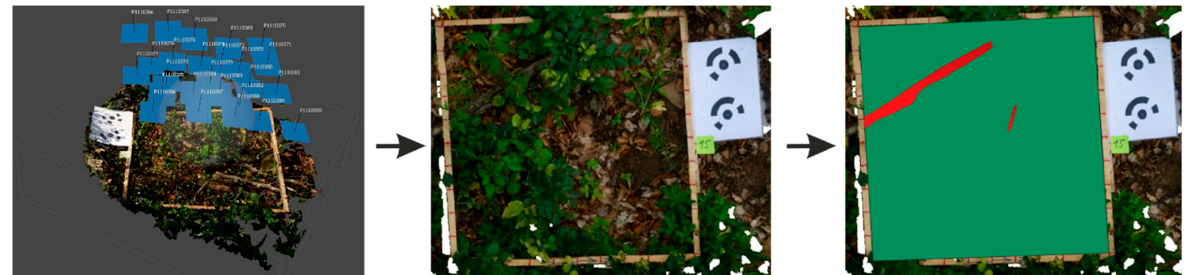
Figure 7. Deriving of orthophoto images of sample plots in Agisoft Photoscan Prof. and polygonisation of deadwood in the orthophoto image.